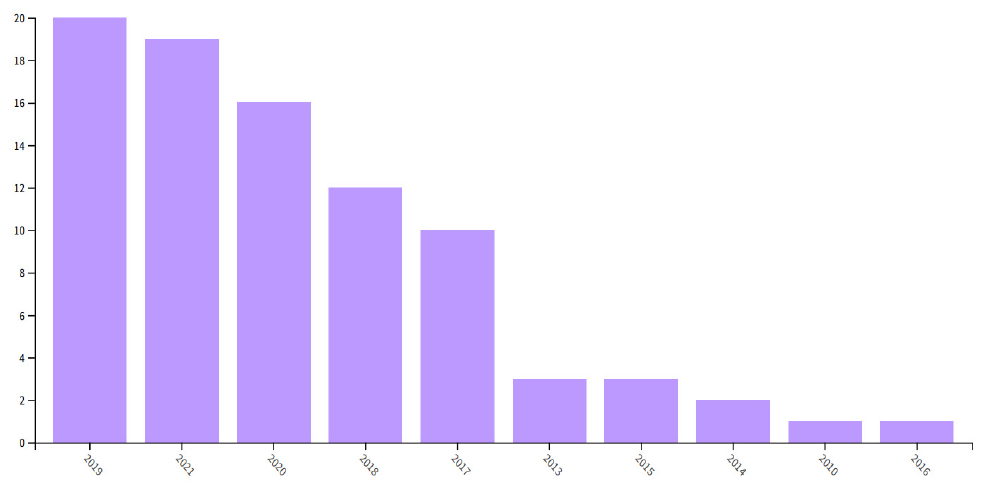
Figure 12. Trends of collaborative and risk in BIM recently.